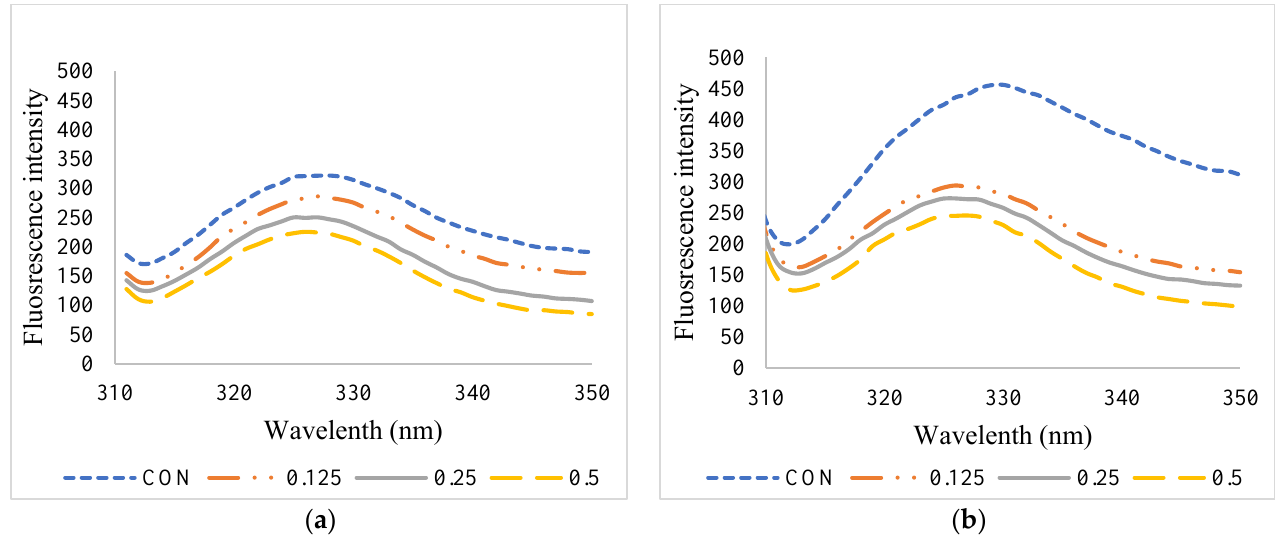
Figure 1. Fluorescence intensity of ( a ) freeze-dried (FD) and ( b ) spray-dried (SD) fish myofibrillar proteins (FMP) modified with tannic acid (TA) at varying concentrations. CON: No TA added. Numbers represent the level of tannic acid (%) used for modification.